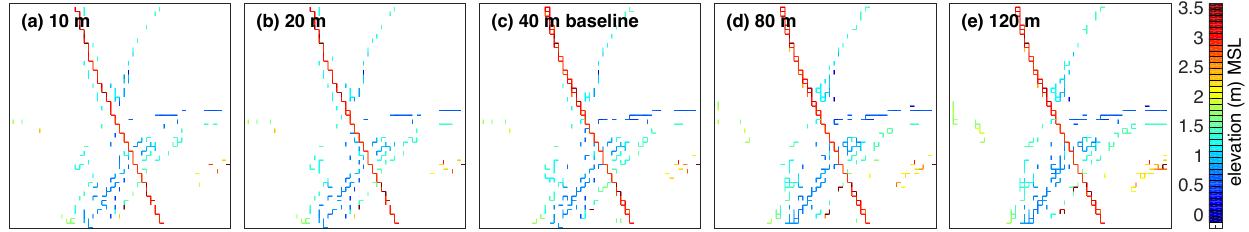
Figure 8. Sensitivity of edge blocking to choice of median filter scale, (cid:49)M .